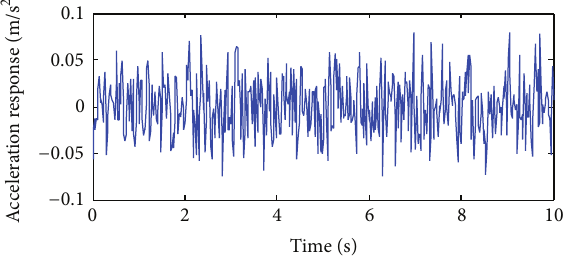
Figure 8: The acceleration time series in 𝑍 direction of the first load case. Table 3: The data for training, validation, and